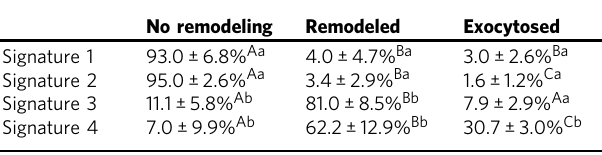
Table 1 Statistical analysis of zinc signature and